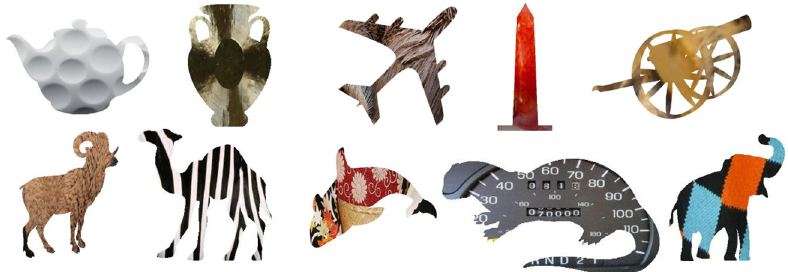
Fig 2. Sample stimuli used in Experiment 1. The bounding shape of an object was combined with the texture of a different object to generate each image. a) Shape: Teapot | Texture: Golf ball; b) Shape: Vase | Texture: Gong; c) Shape: Airplane | Texture: Otter; d) Shape: Obelisk | Texture: Lobster; e) Shape: Cannon | Texture: Pineapple; f) Shape: Ram | Texture: Bison; g) Shape: Camel | Texture: Zebra; h) Shape: Orca | Texture: Kimono; i) Shape: Otter | Texture: Speedometer; j) Shape: Elephant | Texture: Sock. The full image set is displayed in Figs